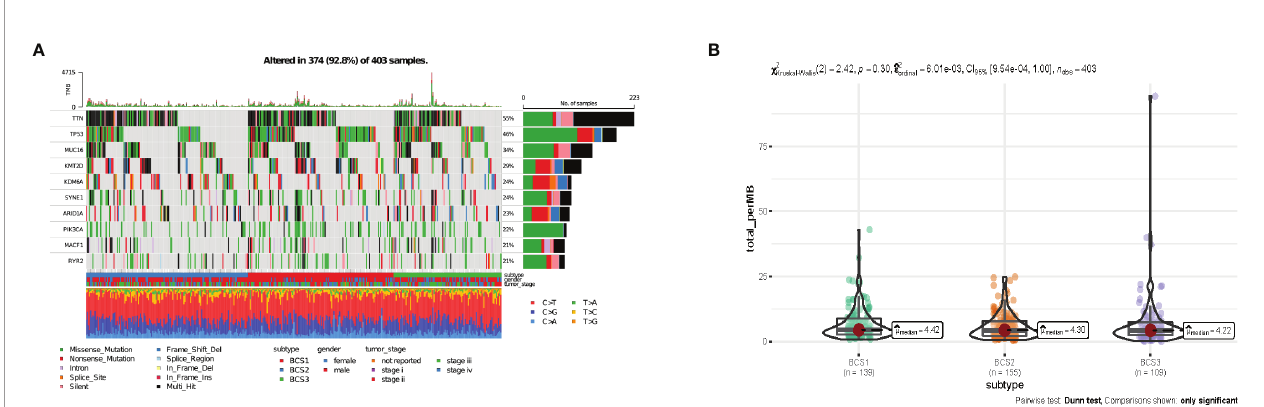
FIGURE 5 | The connection between immune subtyipes and the tumor mutational landscape. (A) Ten highly mutated genes in the BLCA immune subtypes. (B) TMB in BLCA